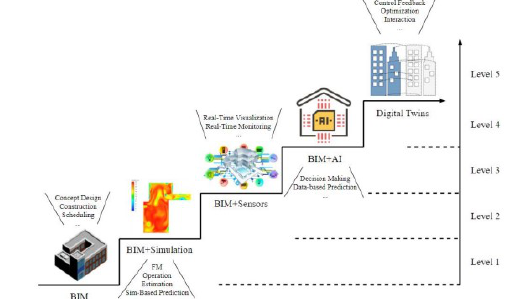
Figure 1. Development stages from BIM to DTs in the Built Environment (Deng et al., 2021)